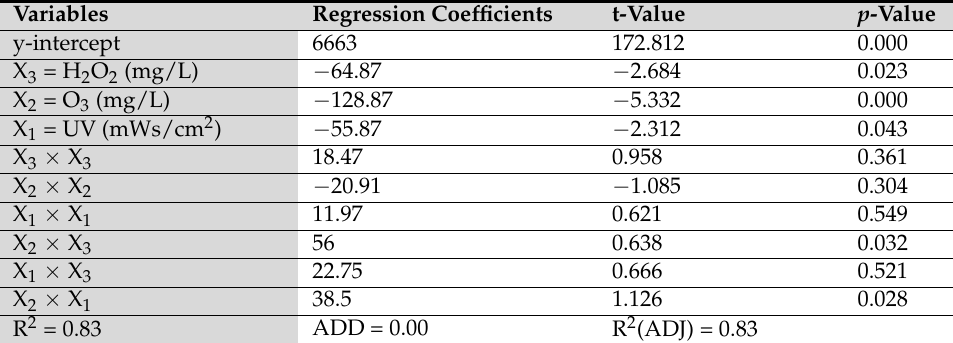
Table 4. Second order regression coefficients for the input factors and response. Variables Regression